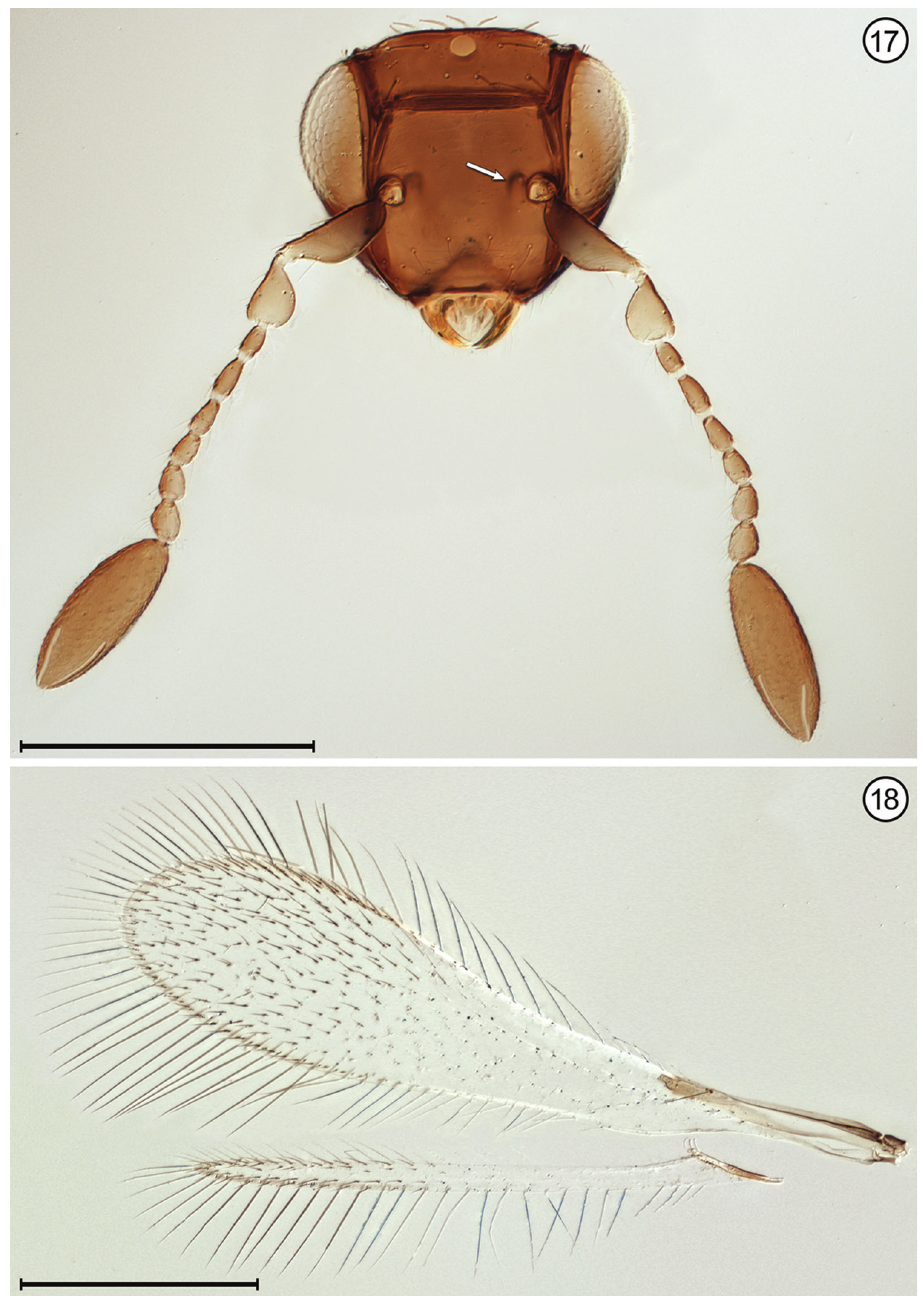
Figures 17, 18. Himopolynema hishimonus , female 17 head, anterior + antennae 18 wings. Scale bars = 100